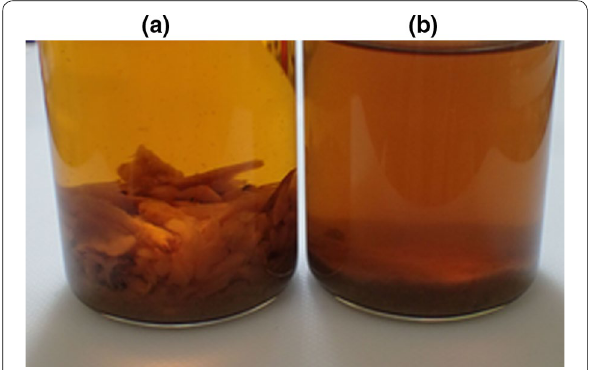
Fig. 1 The cultures after the cultivation of C. cellulovorans with SBP. a Negative control. b The cultivation of C. cellulovorans . SBP used in